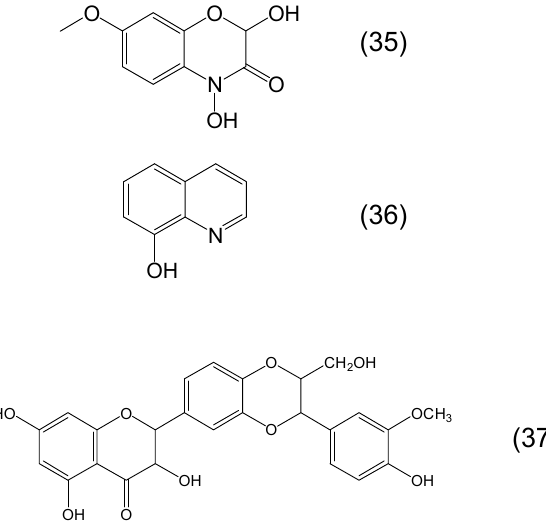
Figure 10. Examples of phytochelators containing a cyclic hydroxamate in the metal binding site and phytochelators used in clinical diagnostics and clinical trials. DIMBOA or 2,4-dihydroxy-7-methoxy-1,4-benzoxazin-3-one ( 35 ), 8-hydroxyquinoline or quinolin-8-ol ( 36 ), silibinin or (2 R ,3 R )-3,5,7-trihydroxy-2-[(2 R ,3 R )-3-(4-hydroxy-3-methoxyphenyl)-2-(hydroxymethyl)-2,3-dihydro-1,4-benzo-dioxin-6-yl]-2,3-dihydrochromen-4-one ( 37 ).